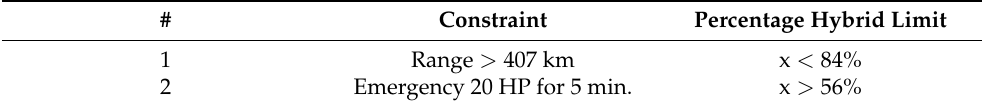
Table 3. Determined values of the upper and lower limits of the percentage of the hybrid system. Source: According [23] processed by